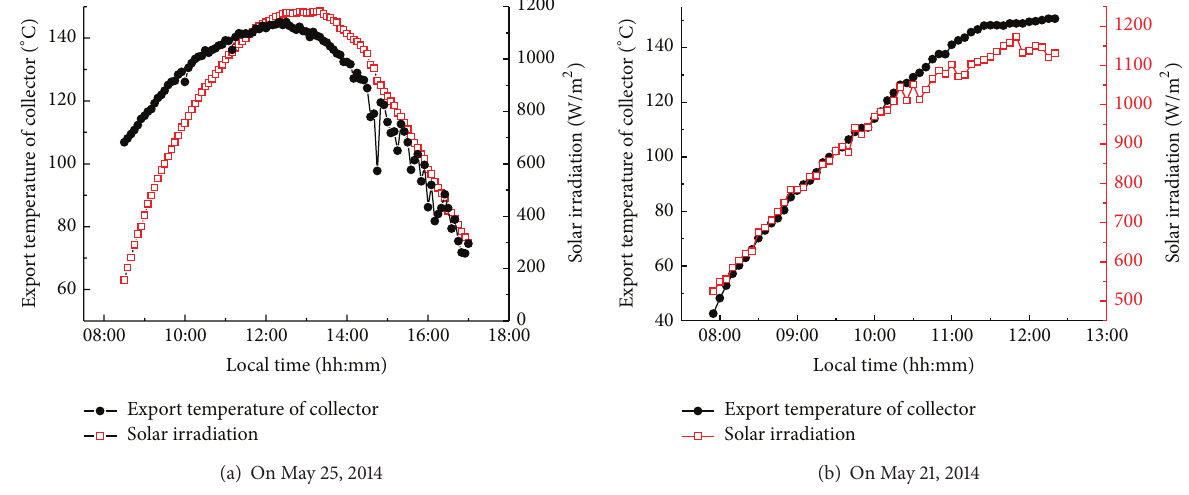
Figure 9: The variations of solar radiation and export temperature of solar collector with